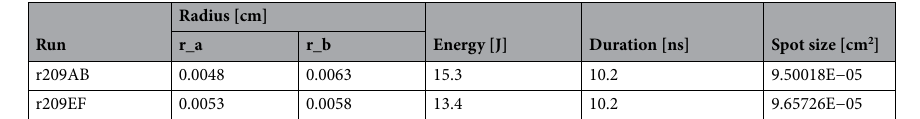
Table 2. Drive laser parameters. Drive laser spatial profile (radius) was made using an equivalent plane monitor at the target position and captured as a CCD tif image. ImageJ was use to extract the illumination profile and FWHM from this image. Energies are calibrated using a diode recording light leakage from a mirror in the laser enclosure. Pulse duration is recorded on an oscilloscope for each